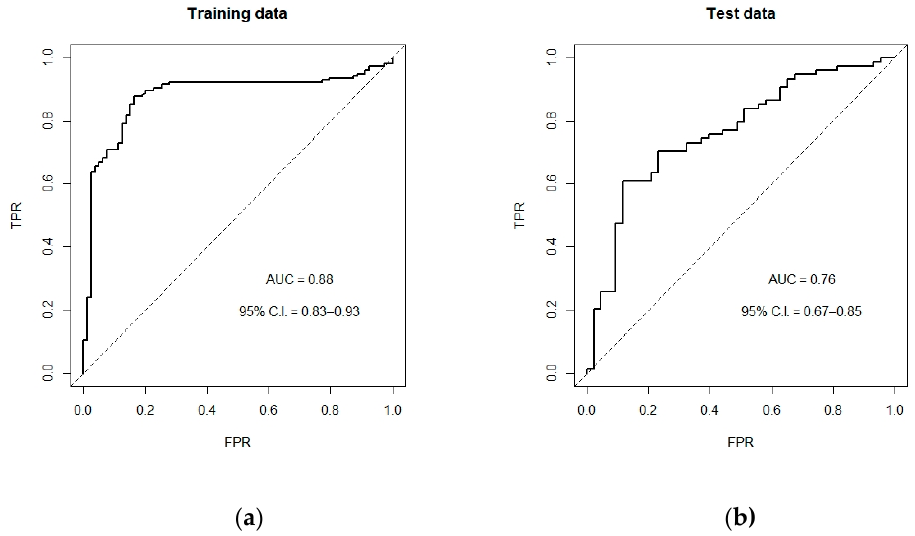
Figure 2. ROC curves of the proposed classifier. ( a ) The AUC and 95% C.I. based on the training data; ( b ) The AUC and 95% C.I. based on the test data.